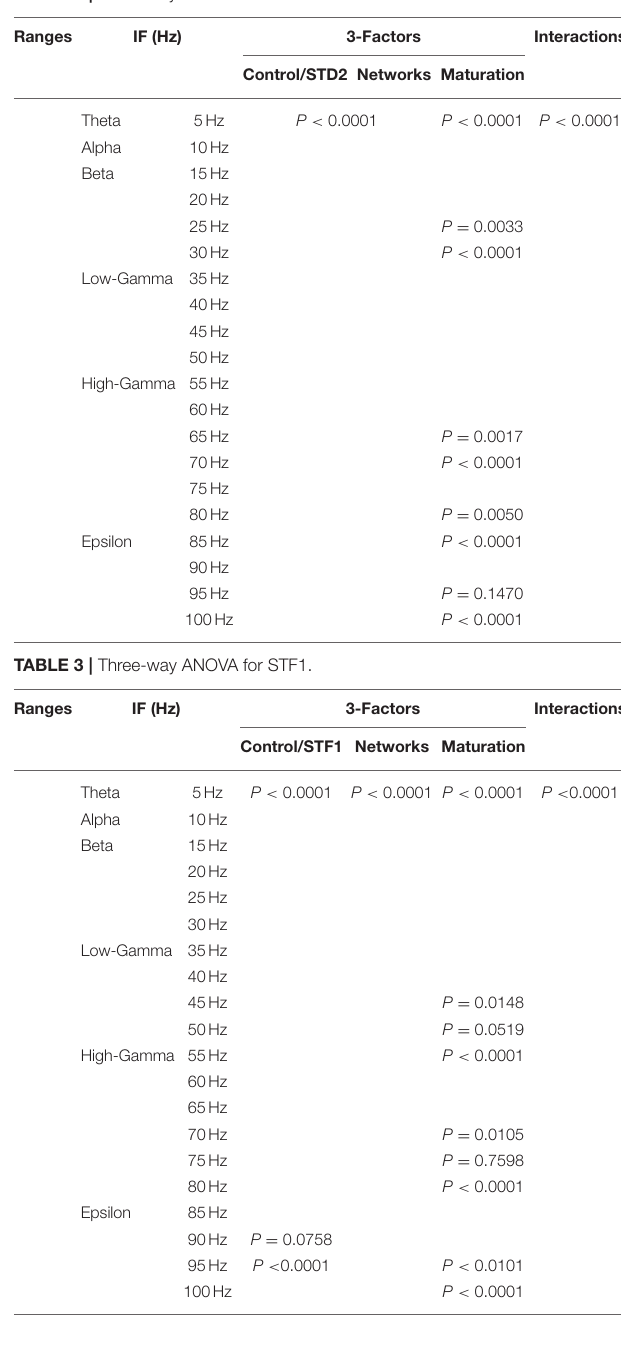
TABLE 2 | Three-way ANOVA for STD2.